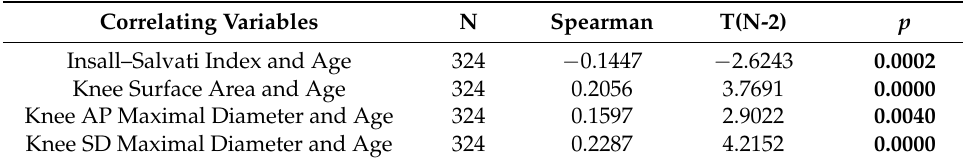
Table 4. Relationship between knee measurement and age.